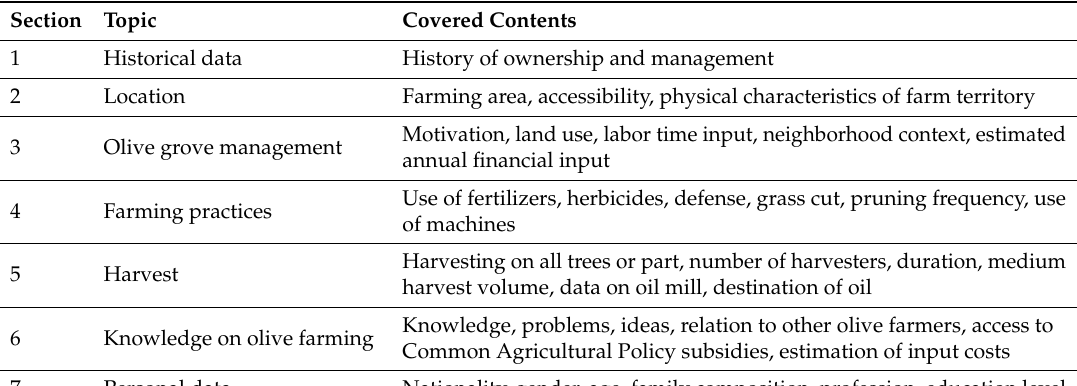
Table 1. Sections of the hobby farmer